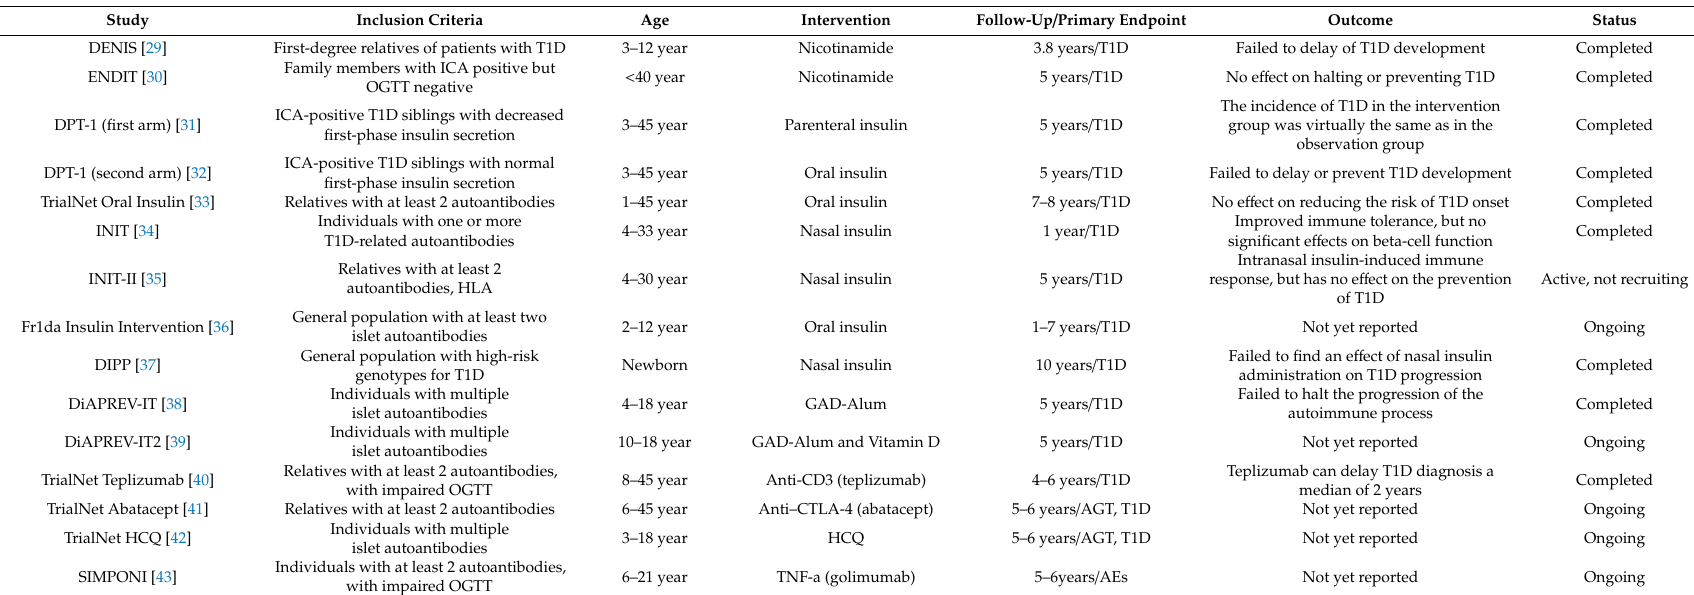
Table 3. Secondary prevention trial in